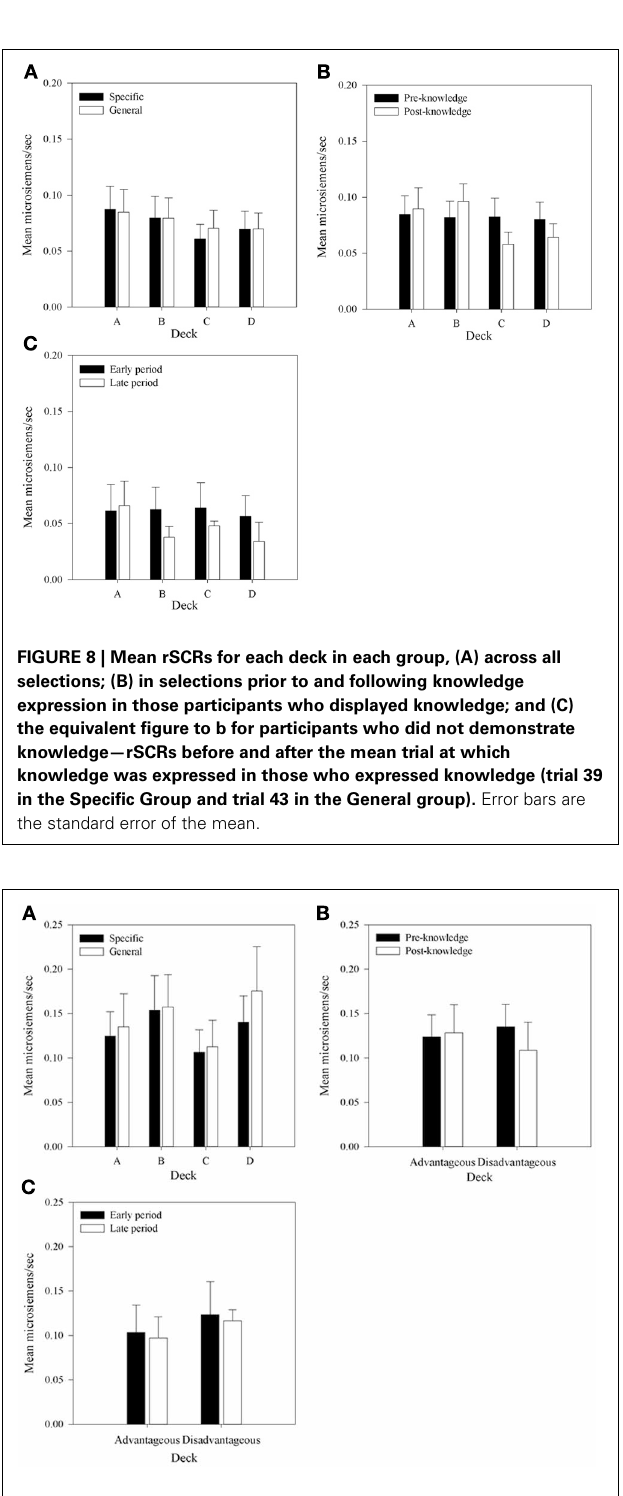
FIGURE 9 | Mean pSCRs for each deck in each group. (A) Across all selections. (B) Mean pSCRs for the advantageous and disadvantageous decks in selections pre- and post-knowledge expression in those participants who displayed knowledge. (C) The equivalent graph to b for the participants who did not demonstrate knowledge ( n = 5)—pSCRs in the period before and after the mean trial at which knowledge was expressed in the majority of each group. Error bars are the standard error of the